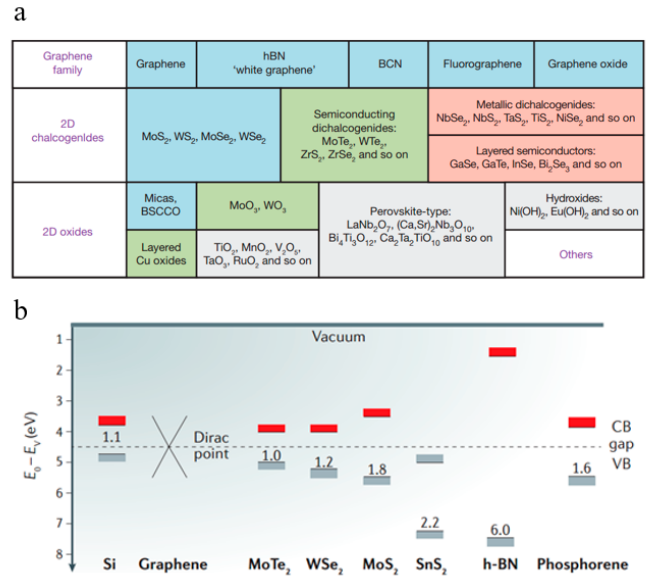
Figure 2. Different 2D layered materials and electronic properties. ( a ) Classified 2D layered materials based on different conductive characteristic. Monolayers proved to be stable in air condition are marked as blue. Those probably stable in air are shaded green. Those monolayers stable in inert atmosphere are shaded pink. Grey shading shows that monolayer can be successfully exfoliated from bulk materials. Reproduced with permission from Nature Publishing Group, Ref [22] ( b ) Band gaps of 2D layered materials compared with Dirac point. Reproduced with the permission from IEEE in Ref [23].